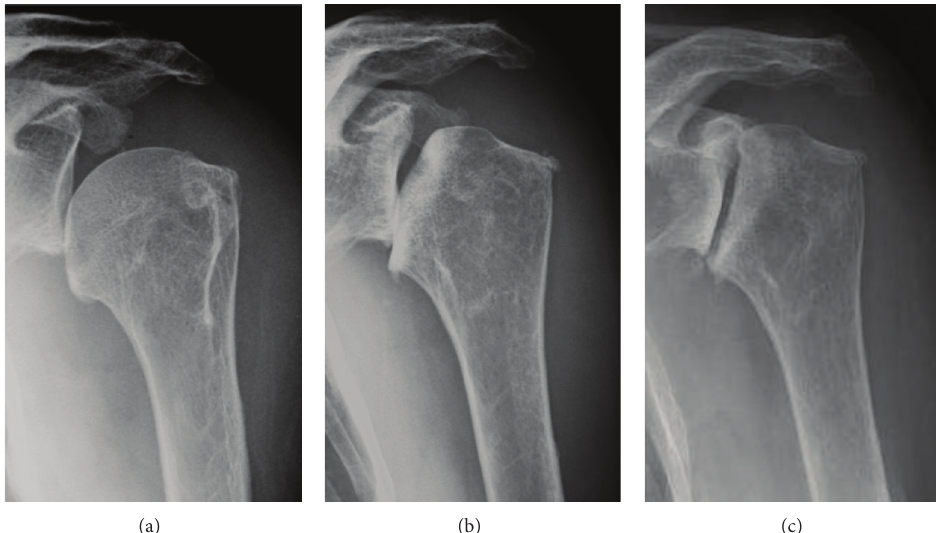
Figure 3: Case 2. Serial preoperative radiographs. (a) The humeral head is slightly displaced inferiorly, but the shape is maintained at the time of symptom onset. (b) Five months later, the humeral head demonstrates progressed collapse. (c) Bone defects of the glenoid are noted 2 years after symptom onset.